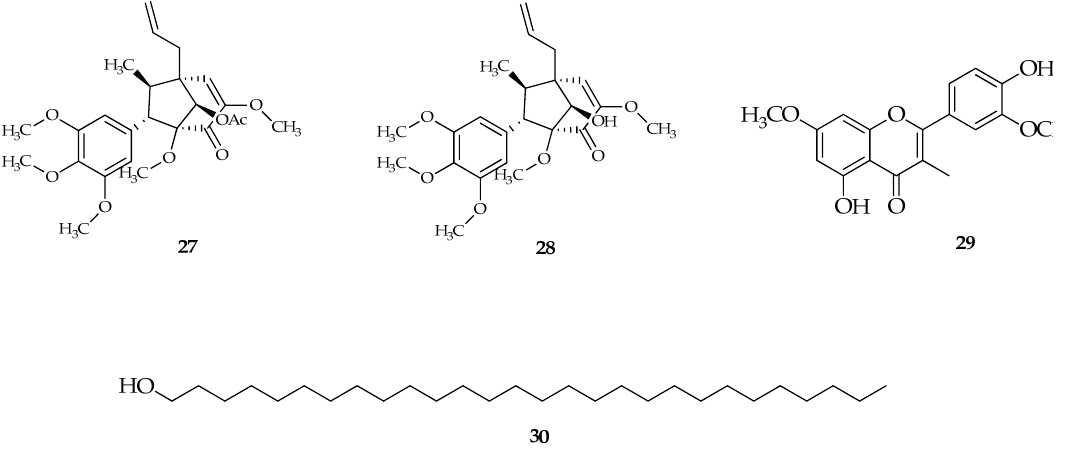
Figure 6. Compounds obtained from the methanolic extract of red betel leaf ( P. crocatum Ruiz and Pav). ( 25 ) β -sitosterol and ( 26 ) 2-(5 ′ ,6 ′ -dimethoxy-3 ′ ,4 ′ -methylenedioxyphenyl)-6-(3 ″ ,4 ″ ,5-trimethoxyphenyl)-dioxabiclo [3,3,0] octane.